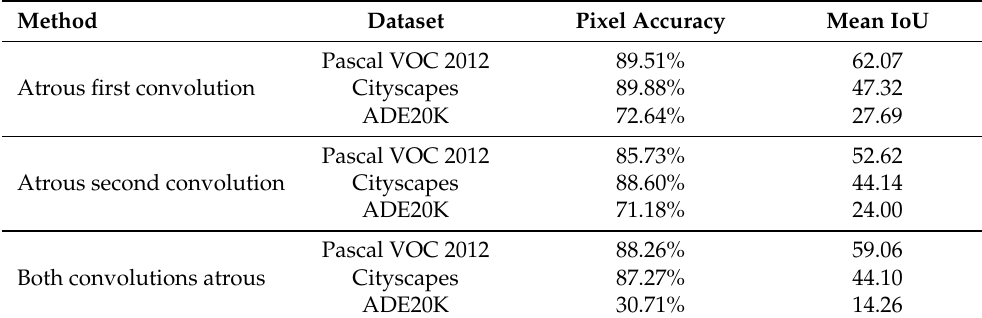
Table 12. Results obtained by dilating convolution from each module from the entry flow in three different